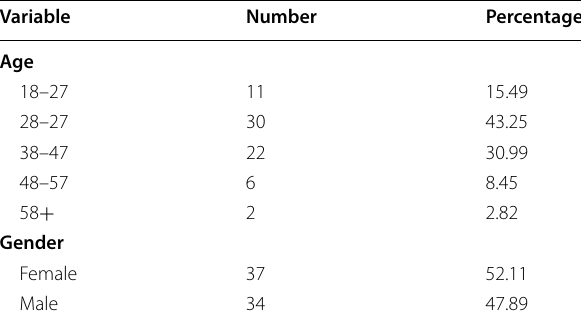
Table 5 Sample description of Guangfu Ancient City